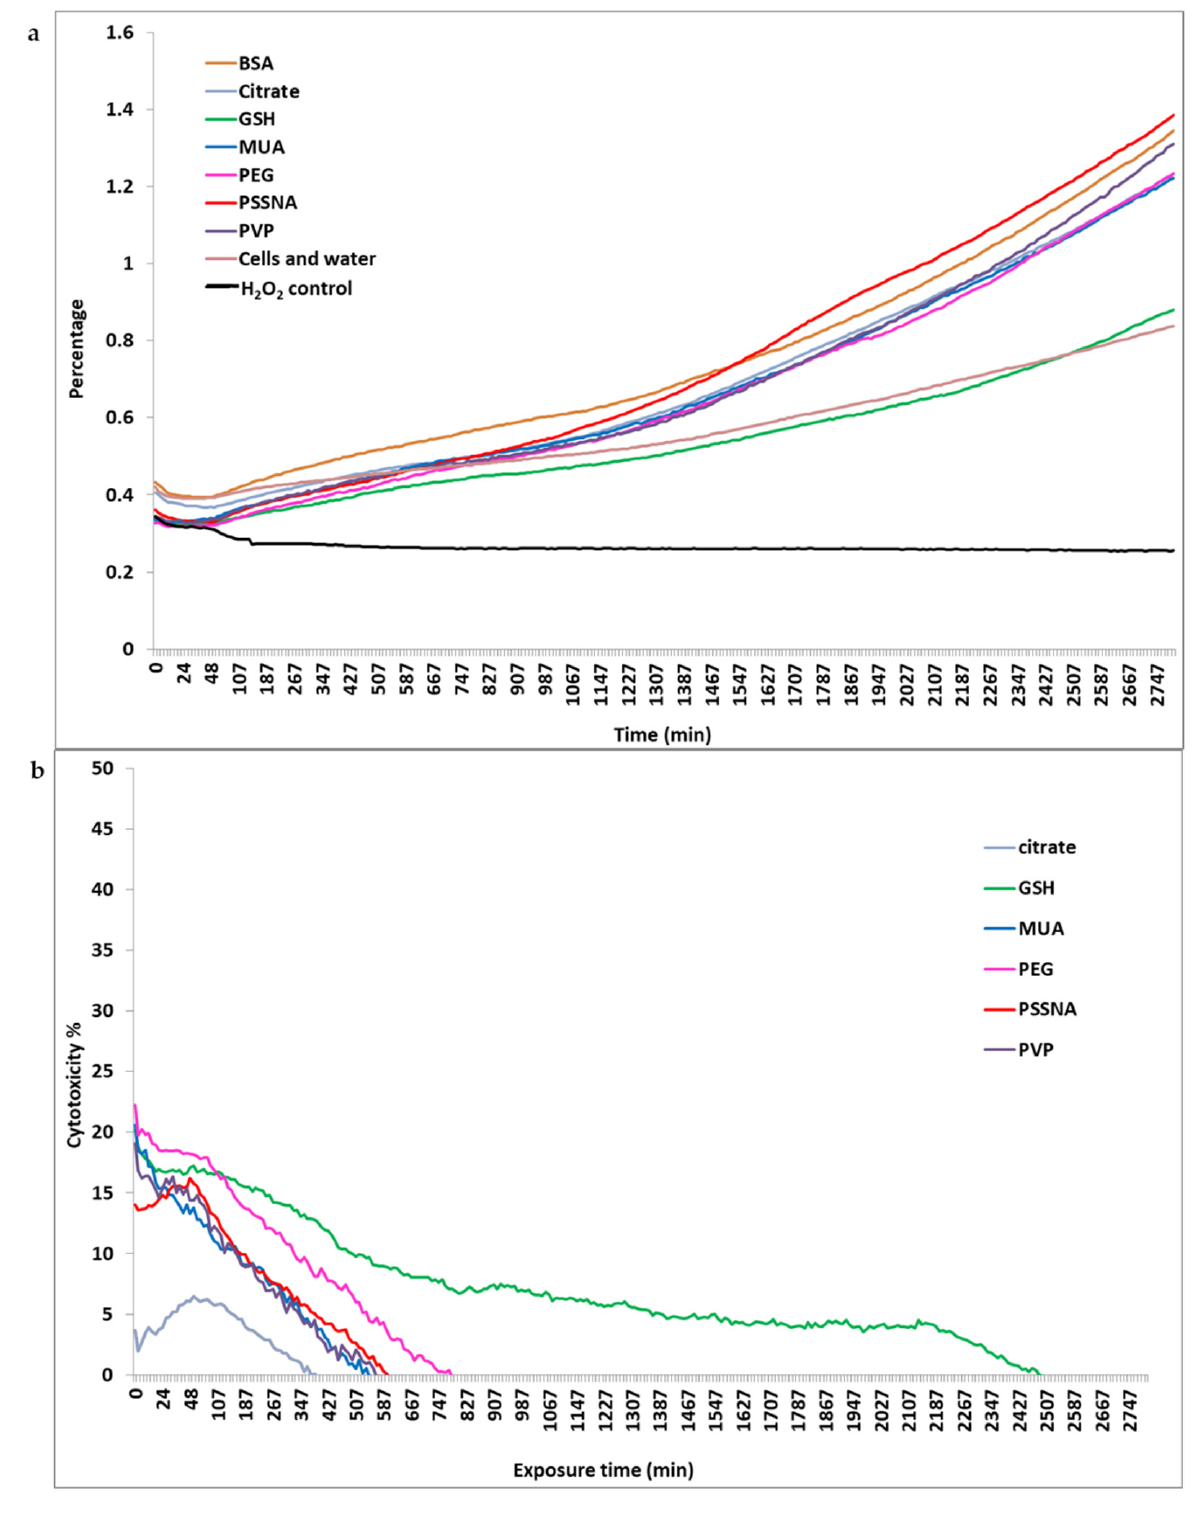
Figure 4. ( a ) Growth curve of the HepG2 cells after dosing them with the GNP-ligands using the IC 30 concentration determined by the impedance of the xCELLigence technology. ( b ) is the inverse graph of ( a ), where the cytotoxicity of the GNP-ligands has been determined. This data is based on an average of triplicate readings obtained for each concentration.